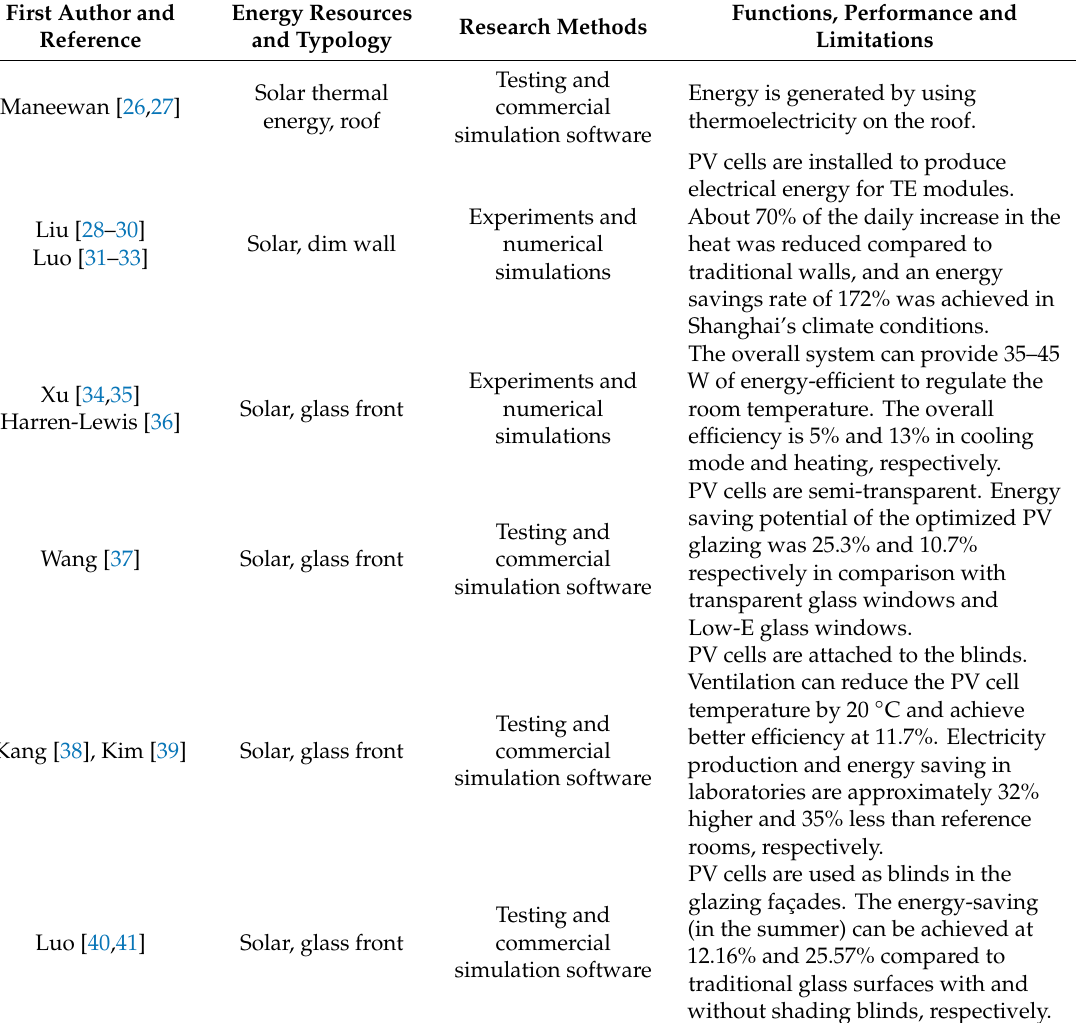
Table 2. Previous studies related to solar